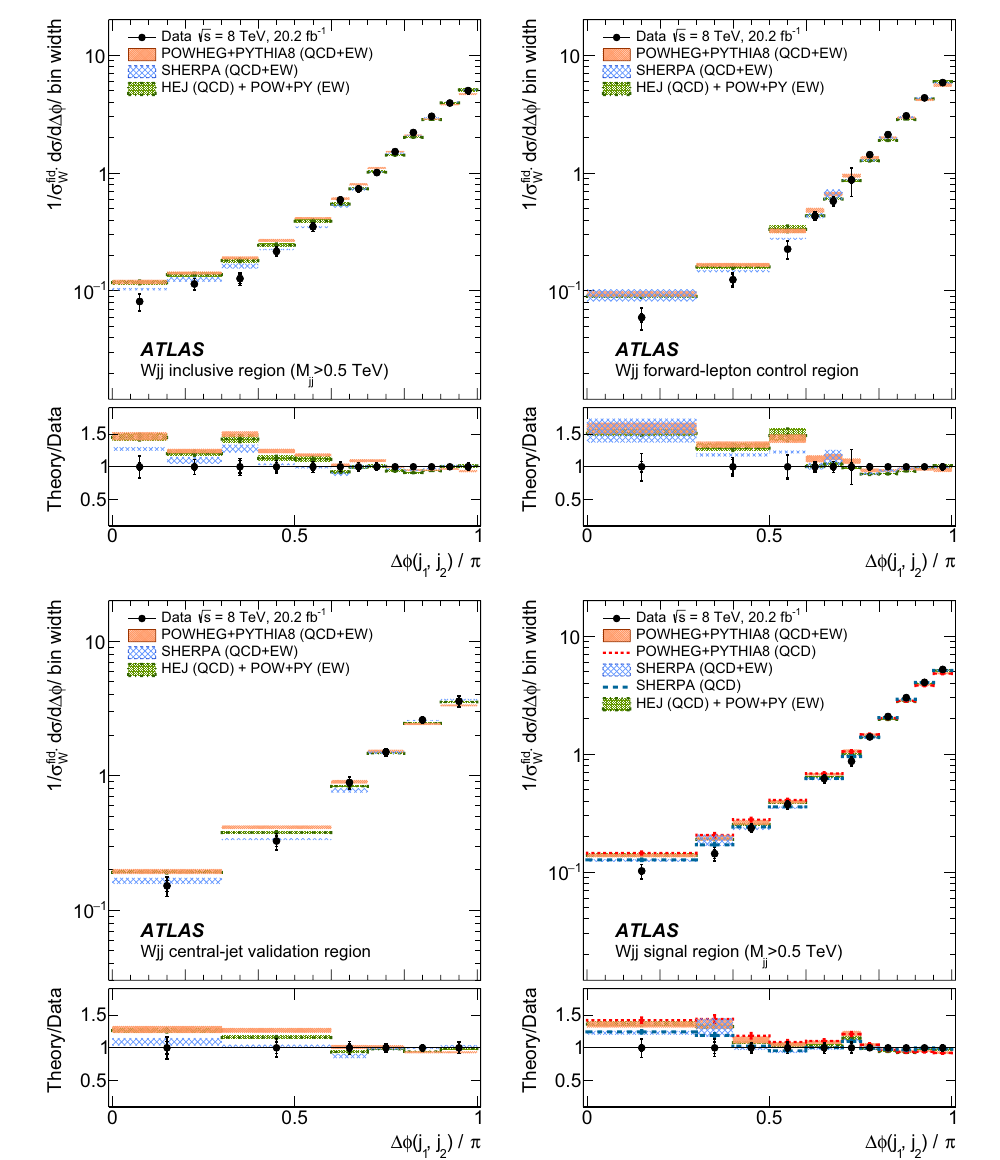
Fig. 47 Unfolded normalized differential production cross sections as a function of (cid:6)φ( j 1 , j 2 ) for the inclusive, forward-lepton control, central-jet validation, and signal fiducial regions. Both statistical ( inner